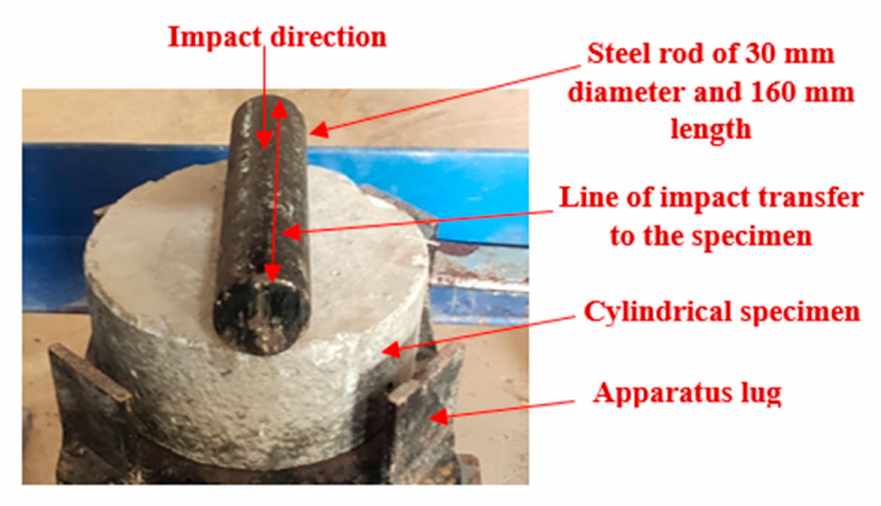
Figure 3. Modification suggested to the ACI drop-weight